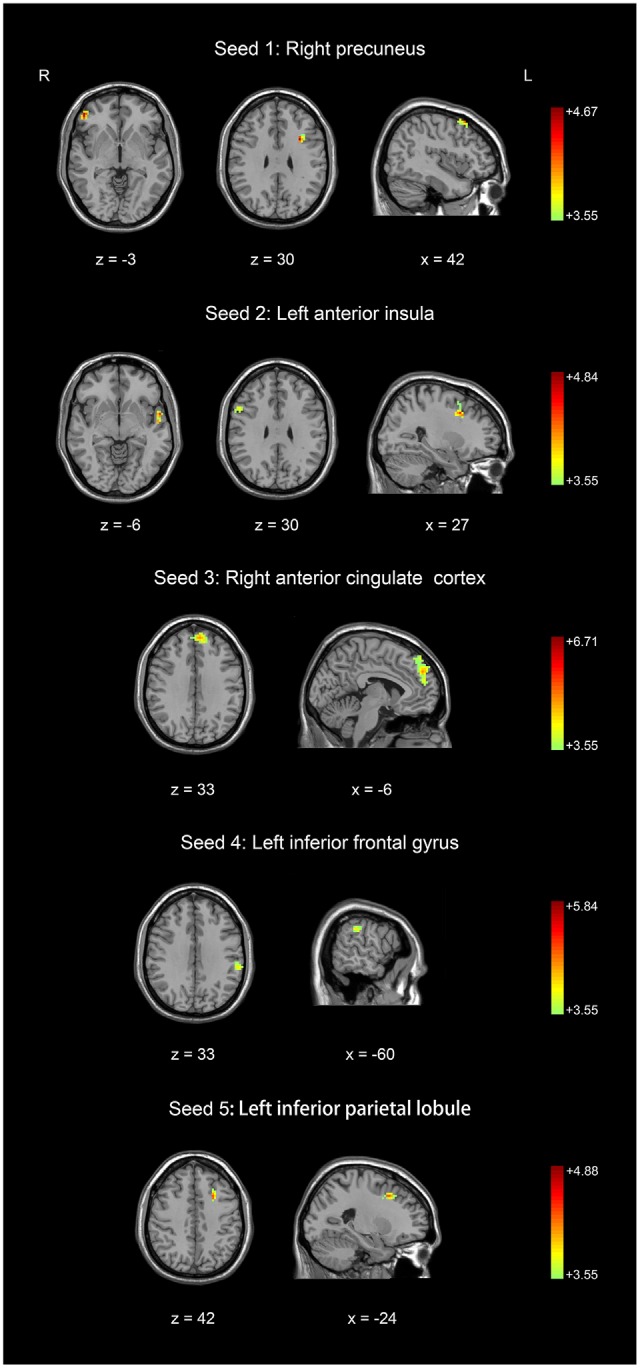
Comparison of resting-state functional connectivity between basketball players and novices. Higher resting-state functional connectivity in basketball players compared to novices was shown. Five seed regions (three in the left brain and two in the right brain) were extracted. Color scale represents the significant t-values (corrected p < 0.05).